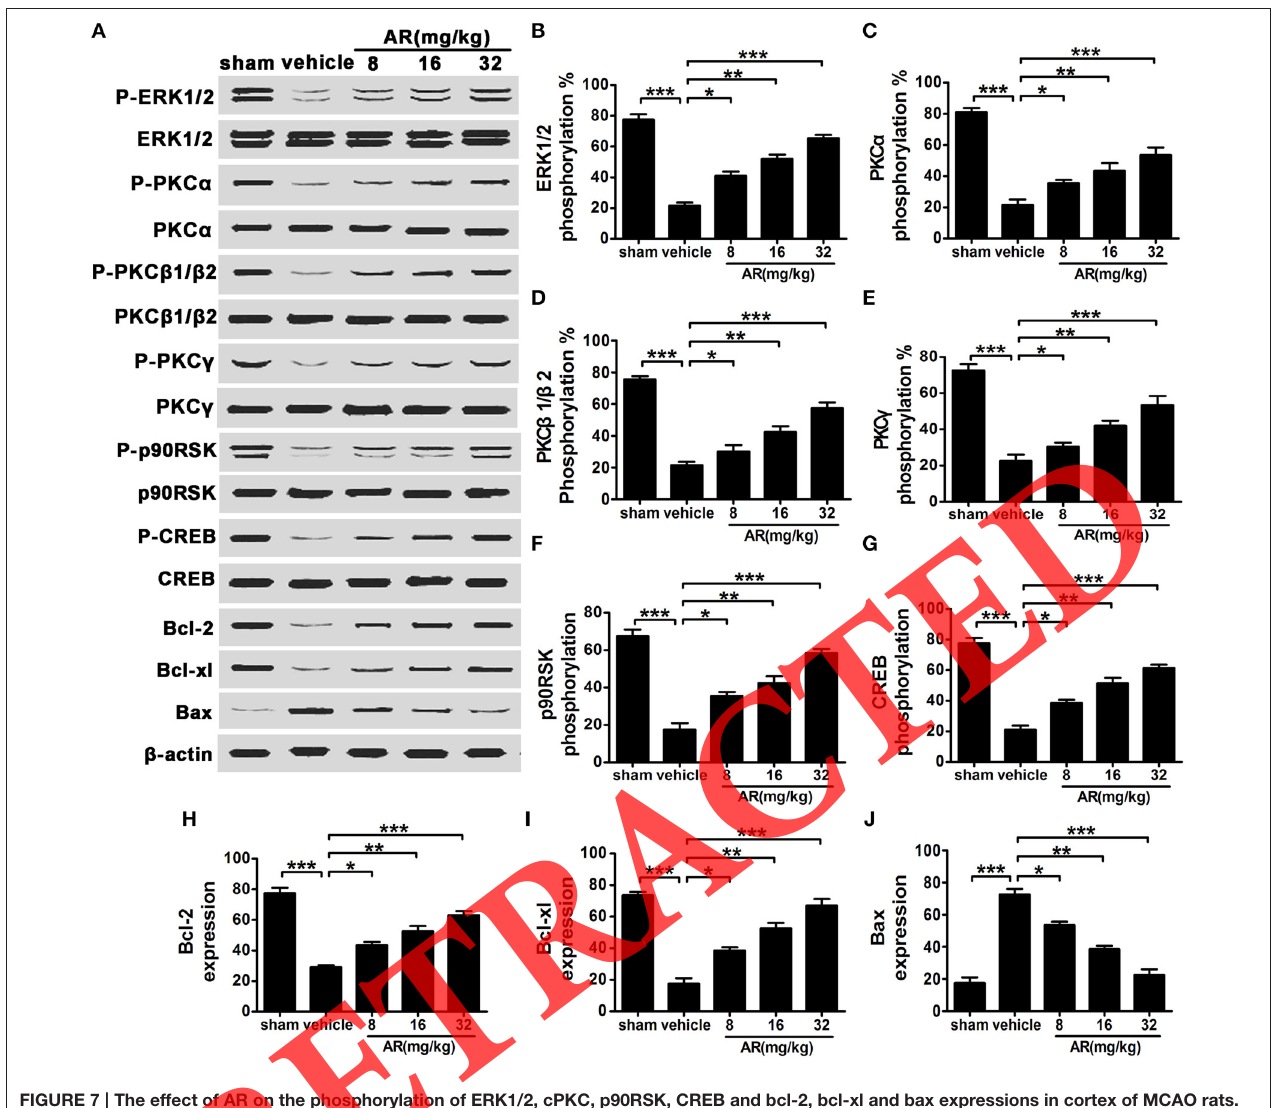
FIGURE 7 | The effect of AR on the phosphorylation of ERK1/2, cPKC, p90RSK, CREB and bcl-2, bcl-xl and bax expressions in cortex of MCAO rats. The vehicle group and AR groups underwent MCAO while the sham group underwent the same surgical procedure without the filament inserted. After MCAO performed, rats in AR groups were intraperitoneally administrated with AR (8, 16, and 32mg/kg) for 3 days. (A) Representative results of ERK1/2, cPKC, p90RSK, CREB phosphorylation alterations and bcl-2, bcl-xl, and bax expressions changes in MCAO rats, and quantification data were described in (B) ERK1/2 phosphorylation level, (C) PKC α phosphorylation level, (D) PKC β 1/ β 2 phosphorylation level, (E) PKC γ phosphorylation level, (F) p90RSK phosphorylation level, (G) CREB phosphorylation level, and (H) bcl-2, (I) bcl-xl, and (J) bax expressions. Results mentioned-above were described as mean ± SD ( n = 8 ). * P < 0.05 ; ** P < 0.01 ; *** P < 0.001